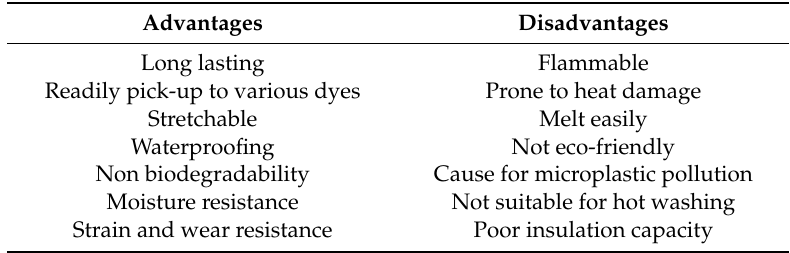
Table 5. Advantages and disadvantages of synthetic